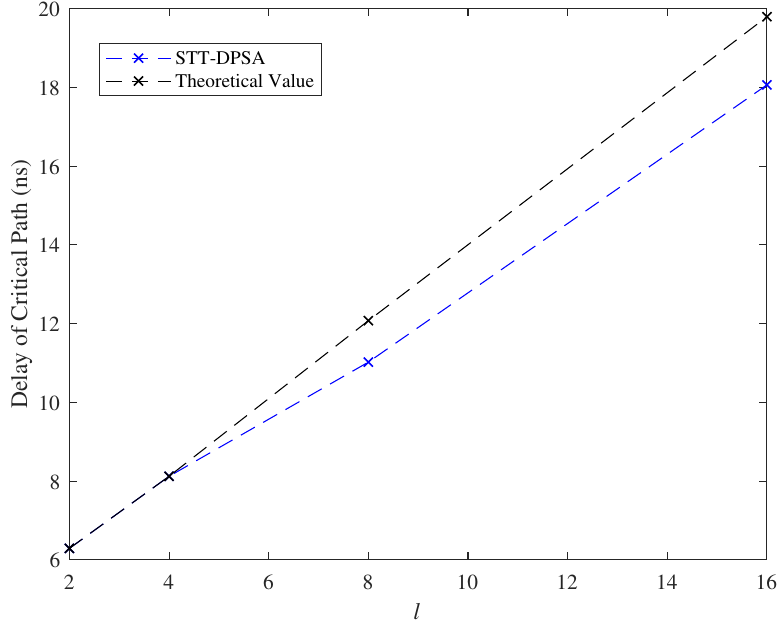
Figure 13. Effect of the parameter l with respect to the delay of critical path.